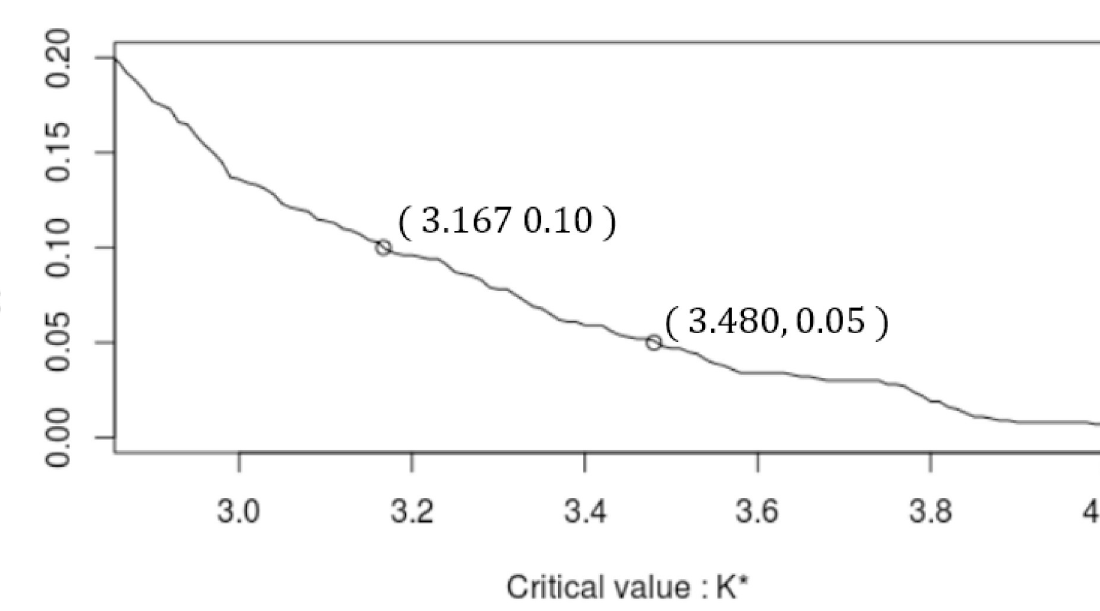
Fig 5. Type1 error probability α v.s. the critical value K � .